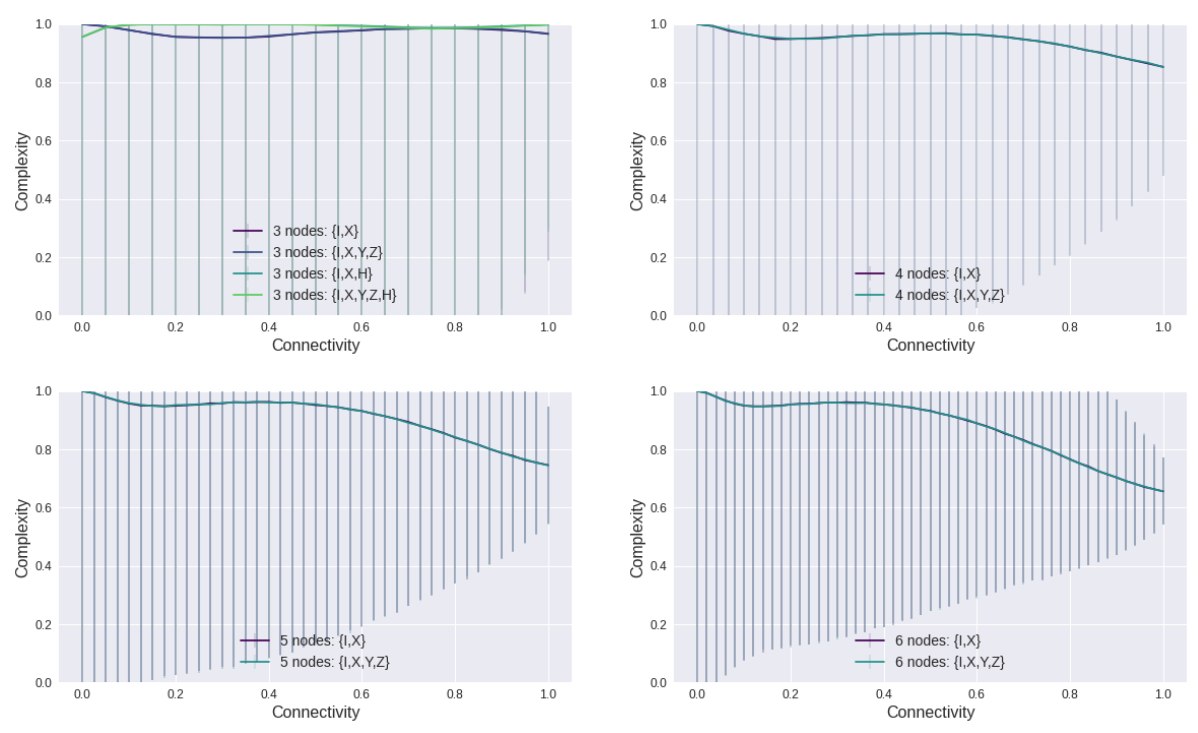
Figure A5. Complexity for QBNs with 3, 4, 5, and 6 nodes. Connectivity is normalized from the range ( 1, N ) . The complexity was computed from 20,000